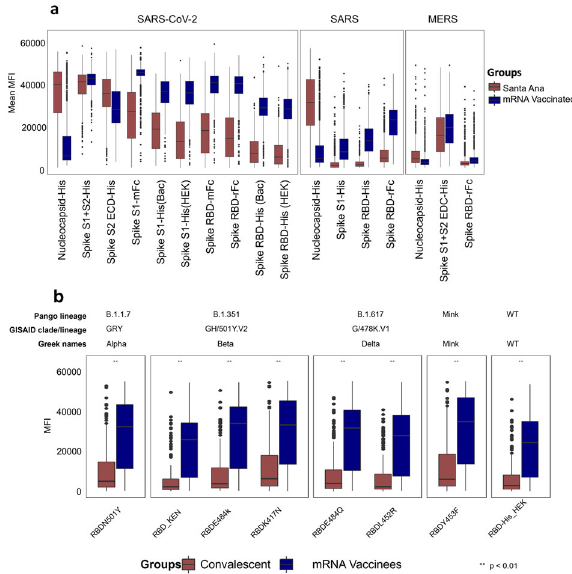
Fig. 4 Natural exposure vs mRNA vaccination antibody reactivity. Mean MFI signals for each of the novel coronavirus antigens in the natural exposure cohort from Santa Ana in December 2020 in brown and the February/March 2021 vaccination group (in blue) are plotted. The boxes represent the fi rst quartile, median, and, third quartile and the whiskers extend 1.5 times the interquartile range (IQR). Wilcoxon test was performed for pairwise comparisons and p values lower than 0.01 were considered signi fi cant and represented as **. Panel a shows that antibody responses against Spike RBD variants are signi fi cantly elevated in mRNA vaccinated people compared to naturally exposed individuals. The b shows that antibody responses against RBD variants from the Coronavirus Pango Lineages B1.1.7, B.1.351, B.1.617, Minkvariant, and the Wild Type. In blue, are individuals that were immunized with a SARS-CoV-